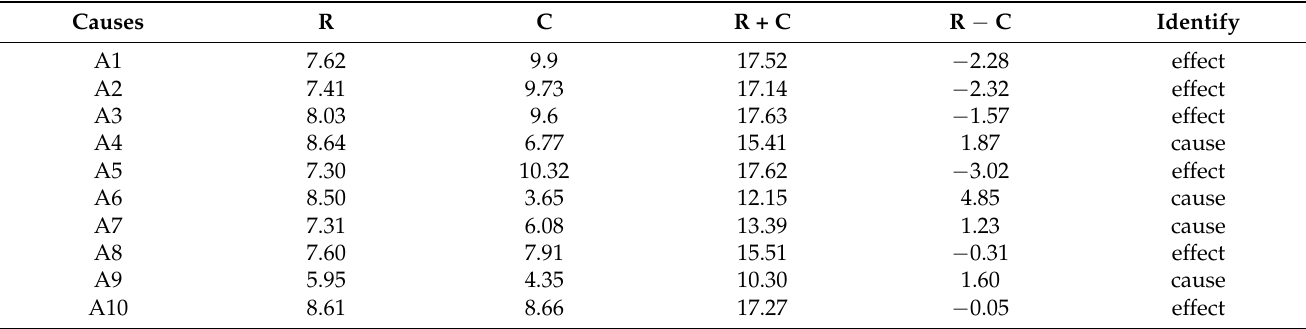
Table 5. Dependence of causes–effects in the problem of porosity cluster on mechanical seal.